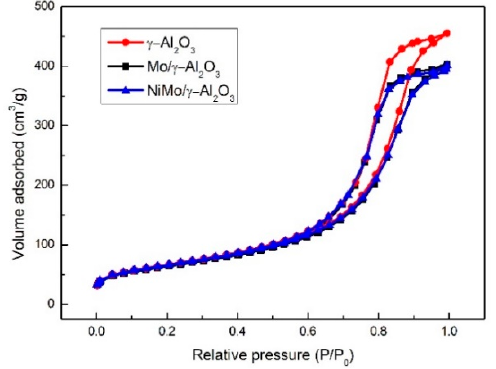
Figure 4. Adsorption and hysteresis isotherms on different stages of the catalyst fabrication.